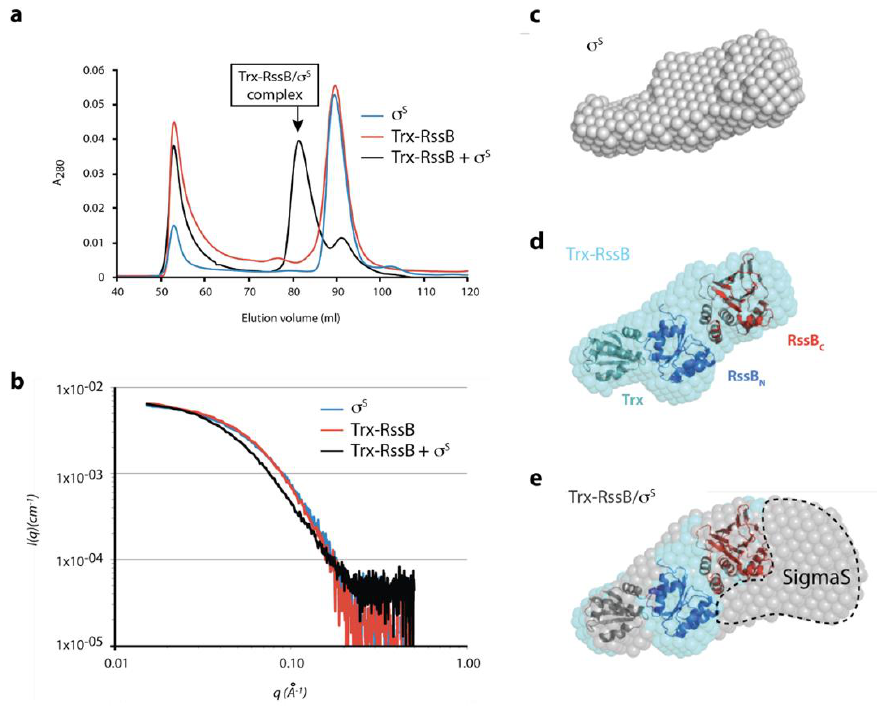
Figure 7. Preliminary SAXS model of the RssB / σ s complex ( a ) SEC elution profile of σ s (blue line), Trx-RssB (red line) and Trx-RssB in complex with σ s (black line). ( b ) Average small angle X-ray scattering (SAXS) data for monomeric σ s (blue line), Trx-RssB (red line), and Trx-RssB in complex with σ s (black line). The intensities are represented as a function of the magnitude of the scattering vector ( I(q) vs. q ). ( c ) the SAXS-derived average ab initio shape envelope for σ s (grey spheres), ( d ) the SAXS-derived average ab initio shape envelope for Trx-RssB (cyan spheres) with Trx-RssB domains: Trx (green), RssB N (blue) and RssB C (red) manually docked into the envelope. Trx was placed into the small protrusion, the N-domain adjacent to it and C-domain distal to Trx. ( e ) The SAXS-derived average ab initio shape envelope for Trx-RssB in complex with σ s (grey spheres), overlaid with the shape envelope of Trx-RssB (cyan spheres) showing individual domains (Trx, RssB N , and RssB C ) from ( d ), highlighting the location of σ s (SigmaS).